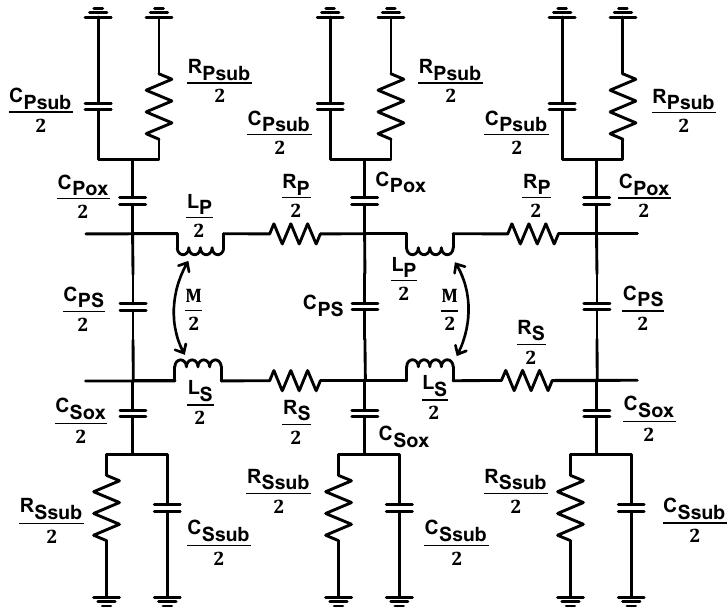
Figure 2. An equivalent model for on-chip transformers based on lumped circuit elements at mm-wave frequency domain [59].